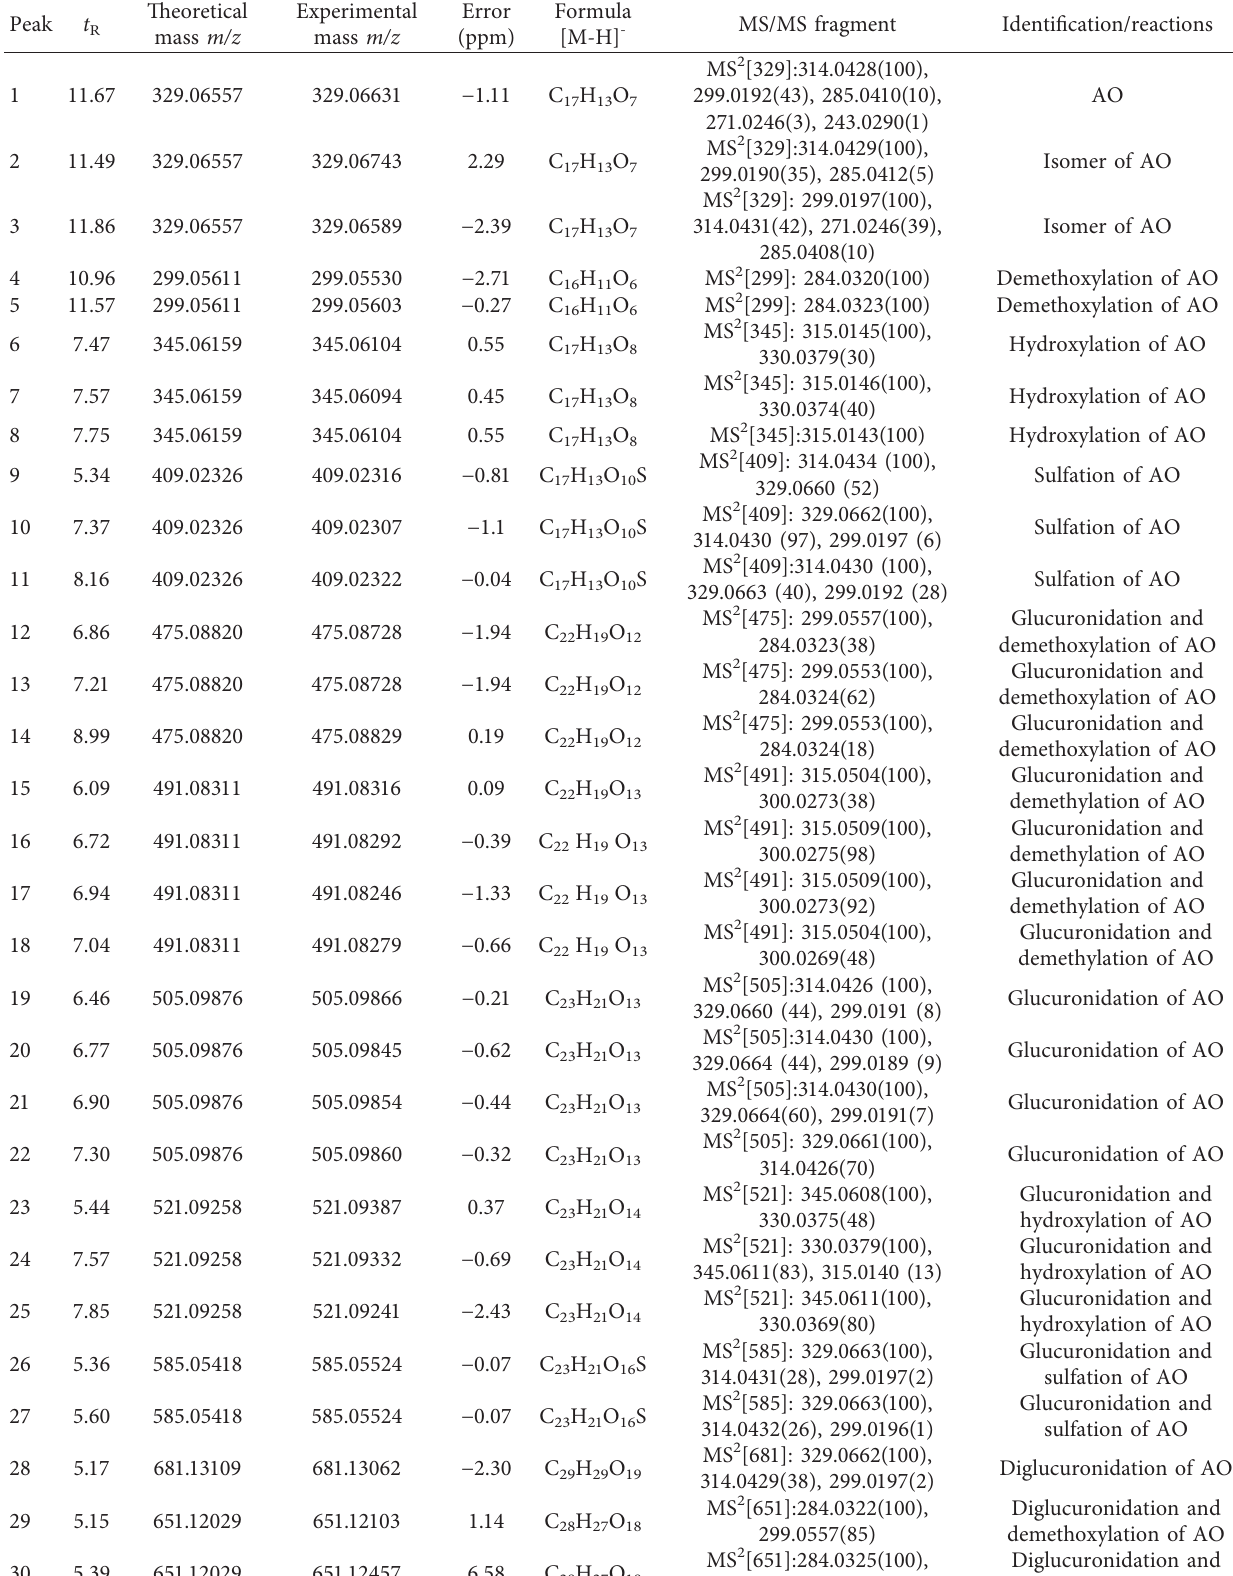
Table 1: The retention time and mass spectrometric data of AO